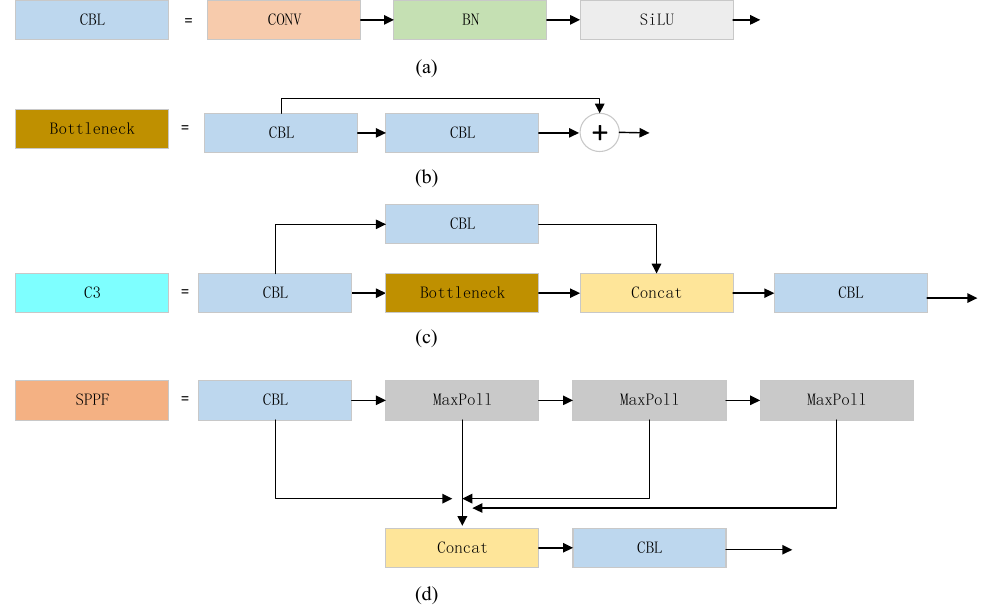
Figure 5. Principal components of YOLOv5: ( a ) CBL; ( b ) bottleneck; ( c ) C3; ( d ) SPPF.